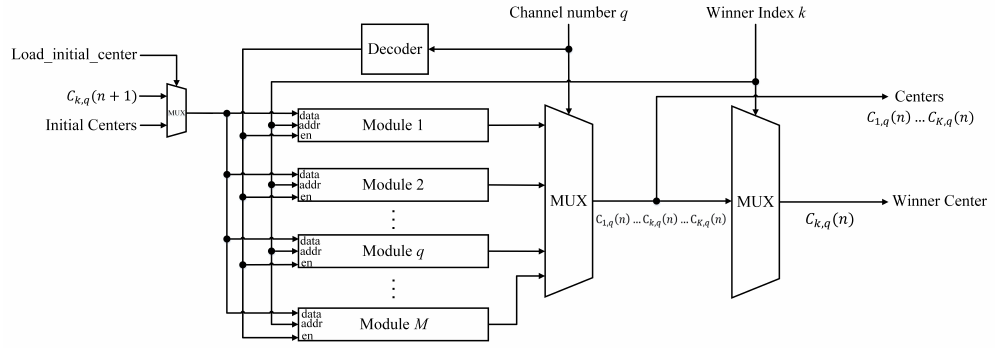
Figure 7. The block diagram of the memory unit. There are M modules in the circuit, where the module q , q = 1,..., M , is dedicated to channel q for CL training and classification. Each module contains K centers associated with its dedicated